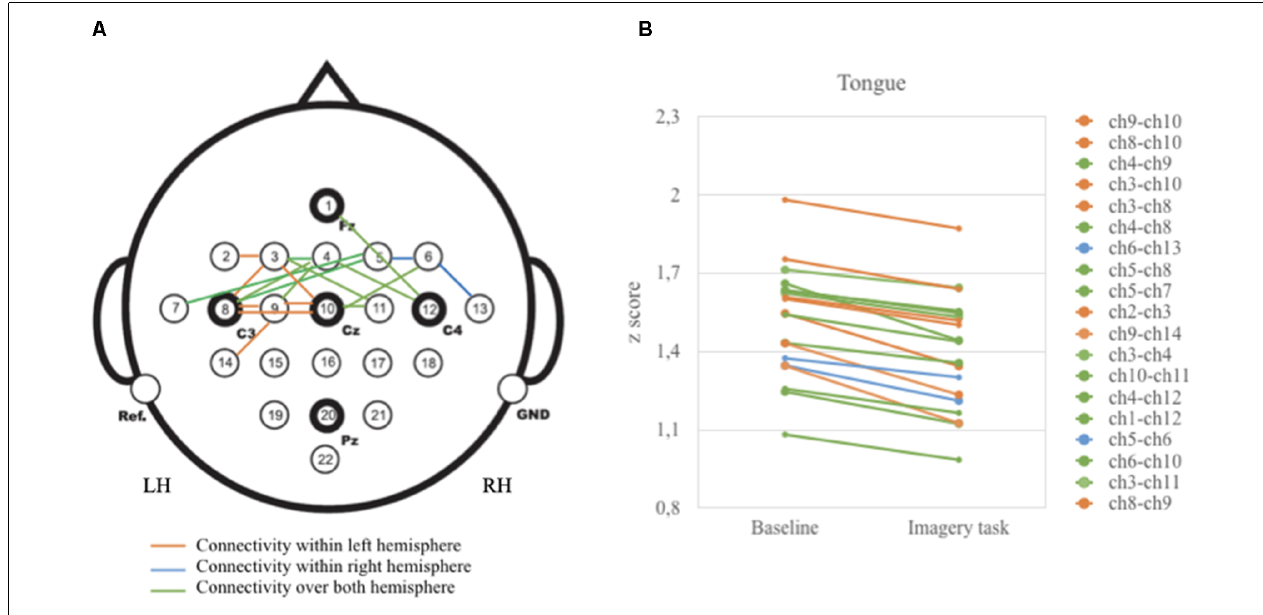
FIGURE 3 | Graphical presentation on the relationship between baseline and tongue imagery task (A) 19 vertices significant correlations (B) configuration of z-scores. Brain activity is reduced when participants performed the tongue imaginative task. Note that vertices correlations were statistically significant for the anterior and central brain areas ( p < 0.05).